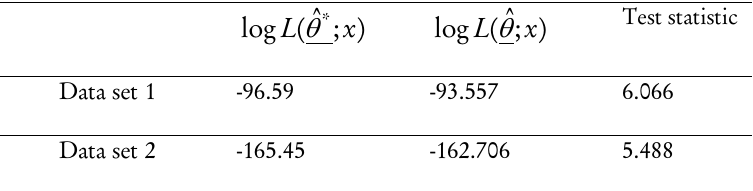
Computed values of the test static for generalized likelihood ratio